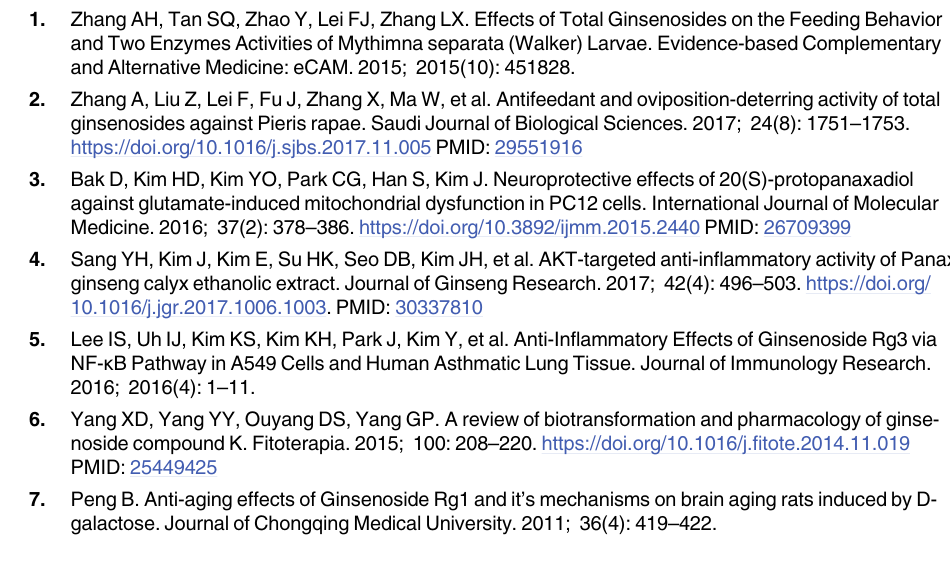
S1 Table. The inhibitory rate of total ginsenosides on hatchability of O . furnacalis eggs at different ages. S2 Table. No-choice antifeedant activity of ginsenosides against the 3 rd -instar larvae of O . furnacalis .